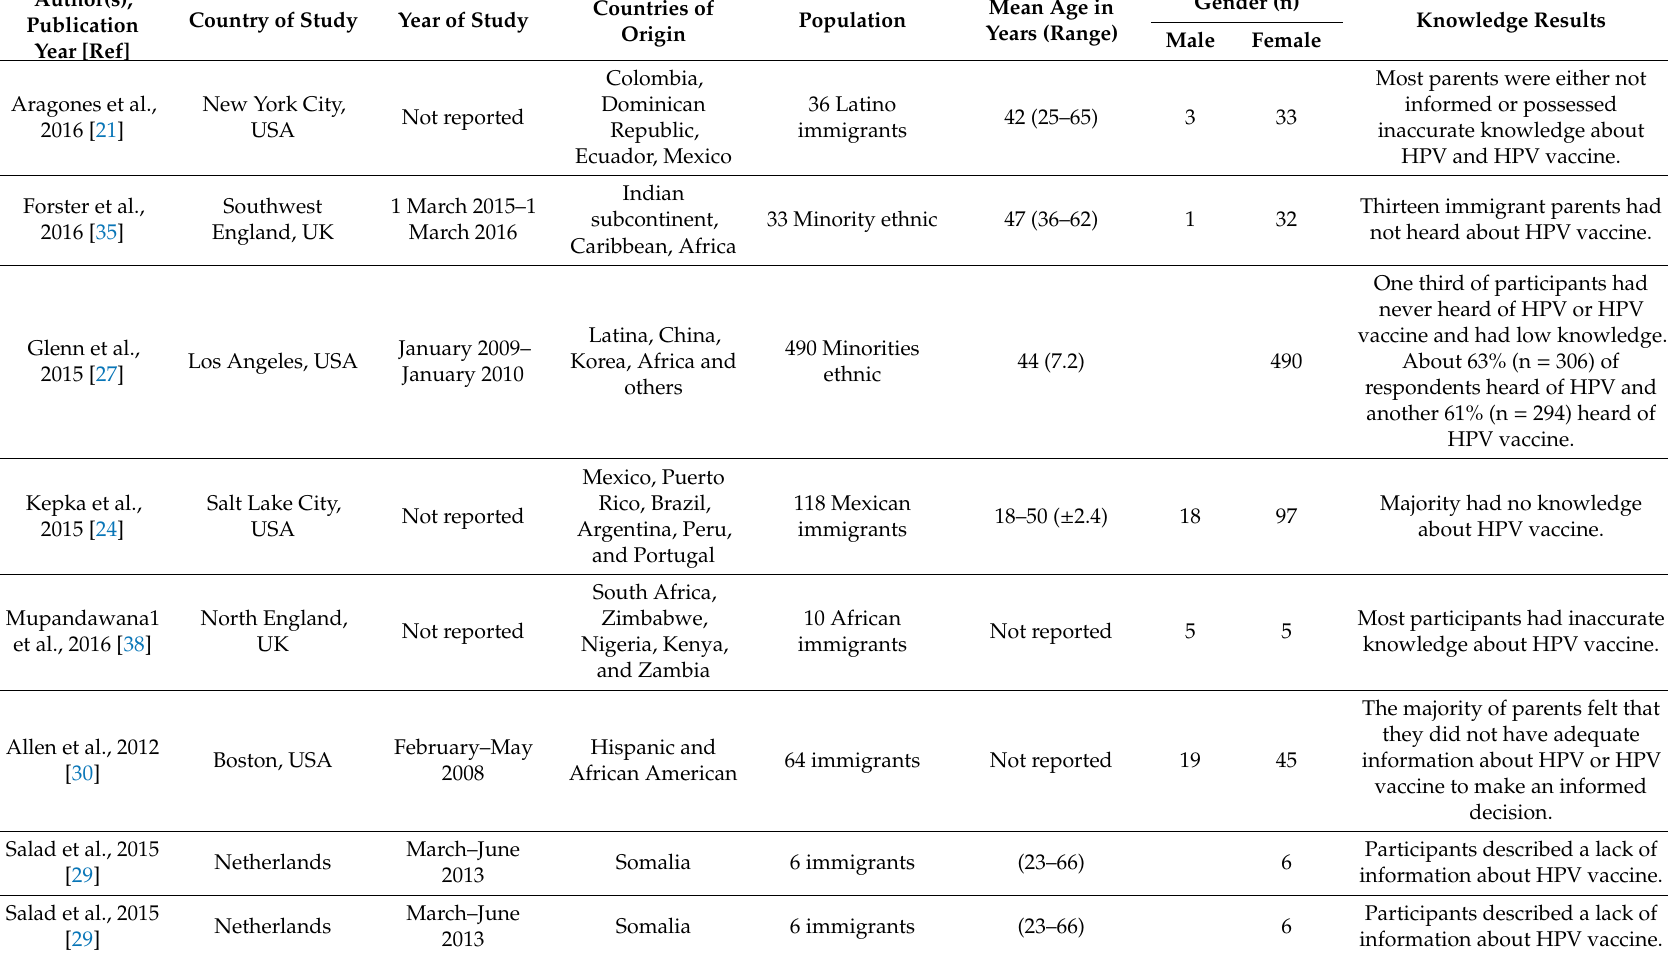
Table 2. Studies reporting knowledge of immigrants about HPV vaccine (16